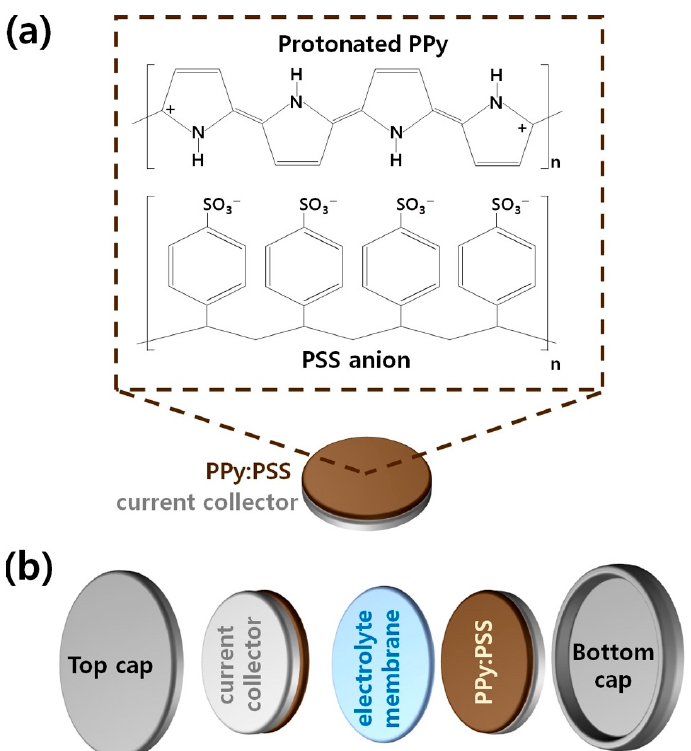
Figure 1. Schematic illustrations of ( a ) A Polypyrrole:Poly(4-styrenesulfonate) (PPy:PSS) electrode, and ( b ) The structure of a two-electrode symmetric supercapacitor based on a coin cell.